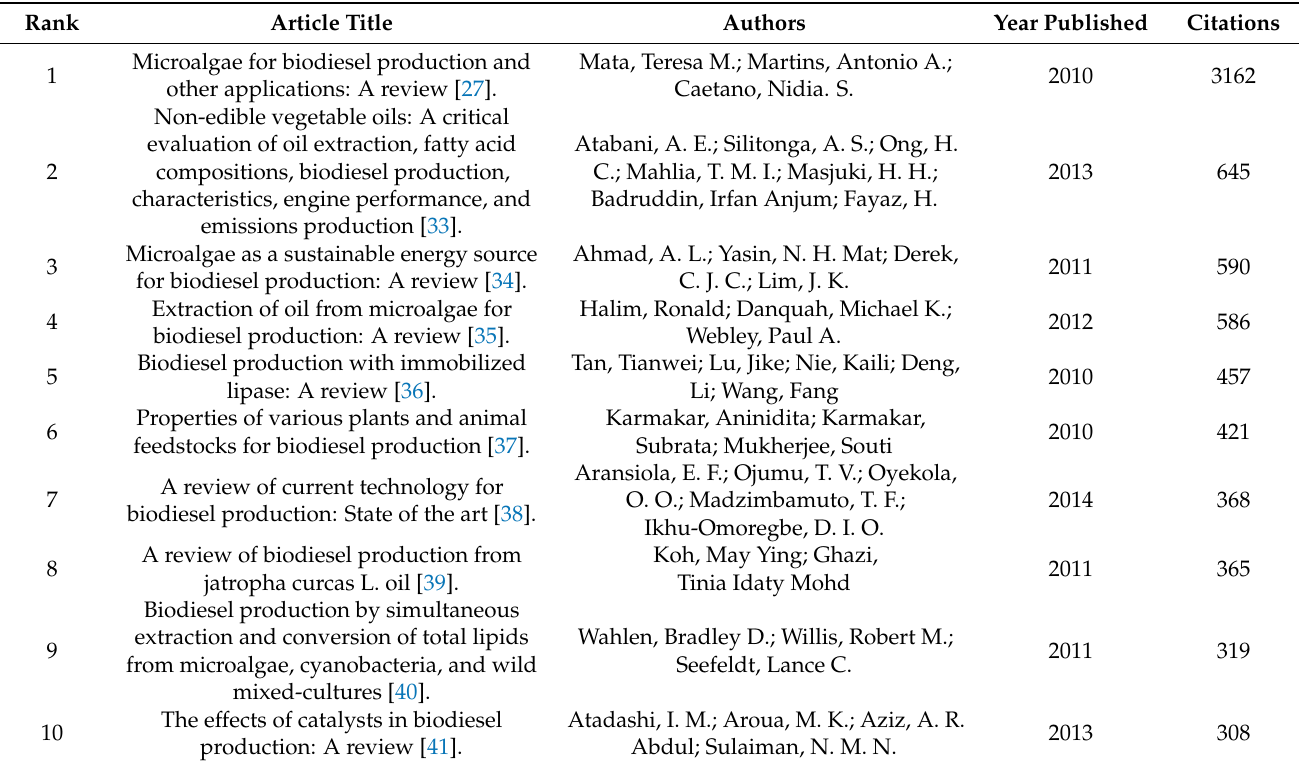
Table 3. Most cited papers in the field of feedstocks for biodiesel